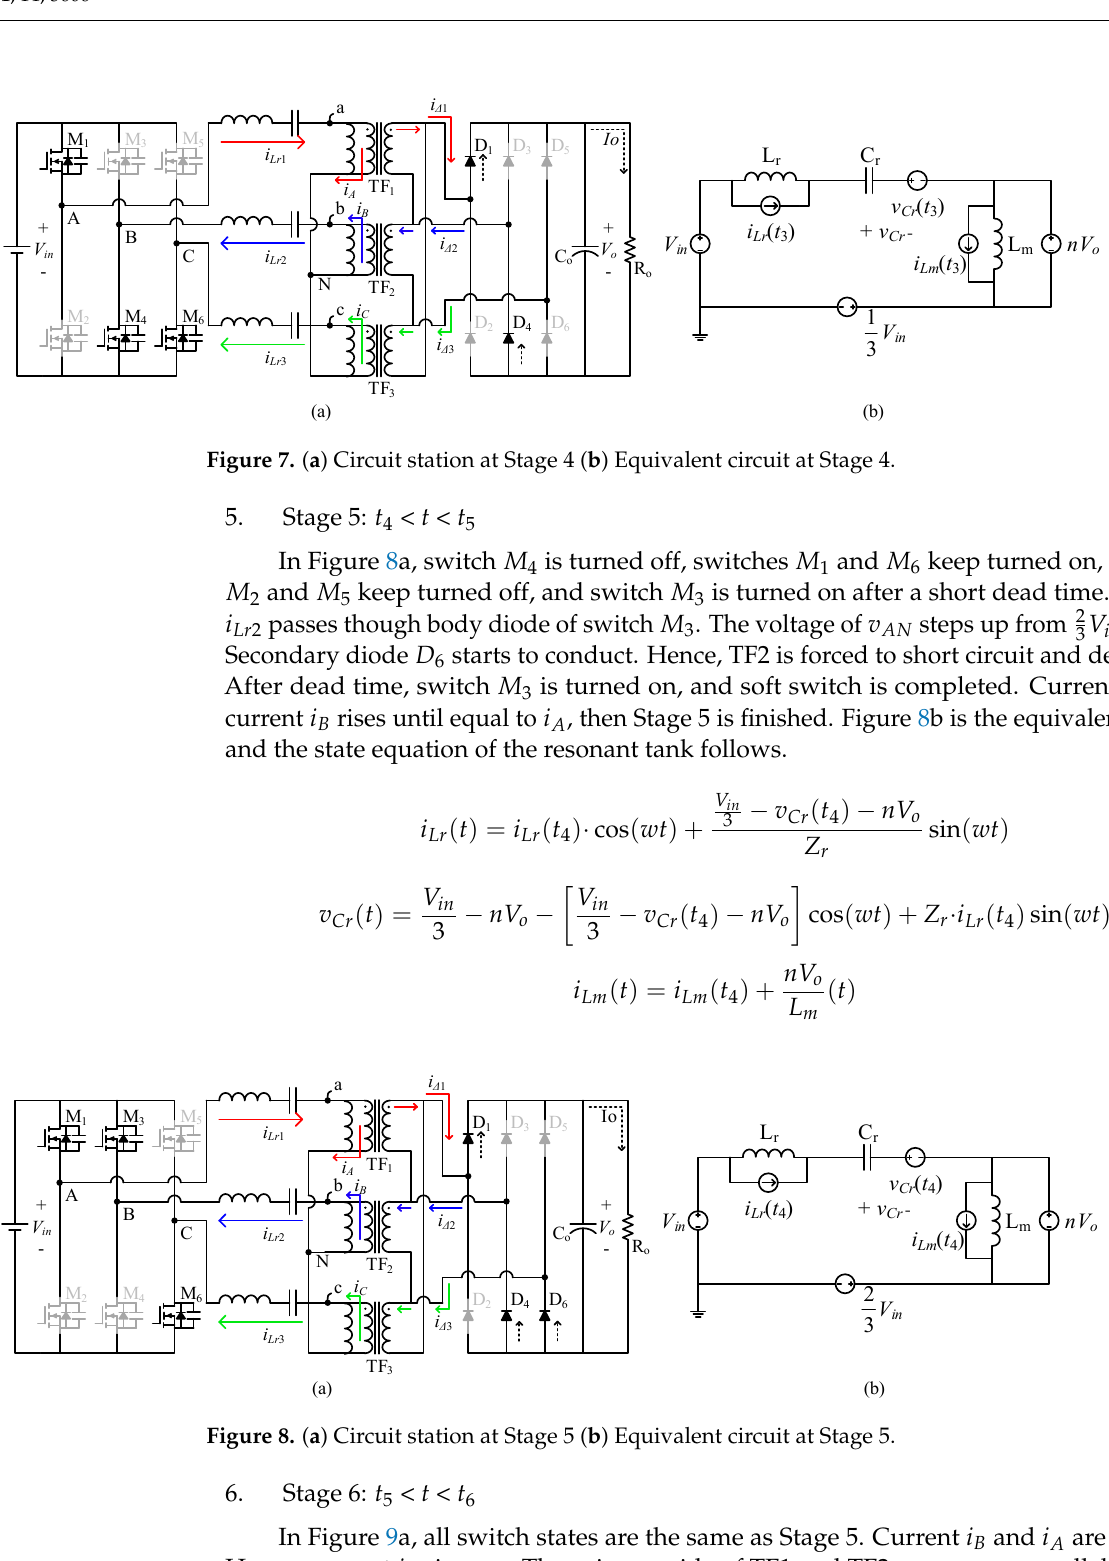
(b) Figure 6. ( a ) Circuit station at Stage 3 ( b ) Equivalent circuit at Stage 3. 𝑖 (cid:3013)(cid:3045) (𝑡) = 𝑖 (cid:3013)(cid:3045) (𝑡 (cid:2870) ) ∙ cos(𝑤𝑡) + 2𝑉 (cid:3036)(cid:3041) 3 − 𝑣 (cid:3004)(cid:3045) (𝑡 (cid:2870) ) − 𝑛𝑉 (cid:3042) 𝑍 (cid:3045)